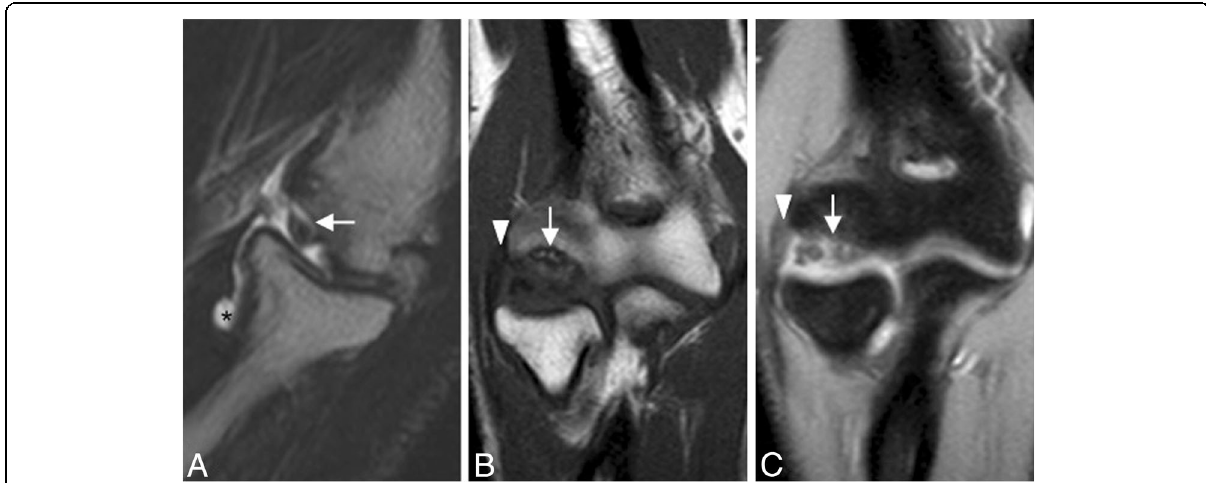
Fig. 32 A 33-year-old female gymnast with elbow pain and instability. Sagittal T2-weighted MRI ( a ), coronal T1-weighted MRI ( b ), and coronal FS PD-weighted MRI ( c ), demonstrating an osteochondral lesion in the posterior capitellum caused by posterolateral rotatory instability. The lesion is unstable, with fluid extending into the interface between the fragment and the parent bone (white arrows). Proximal partial disruption of the lateral ulnar collateral ligament (white arrowheads). Joint effusion (black asterisk)